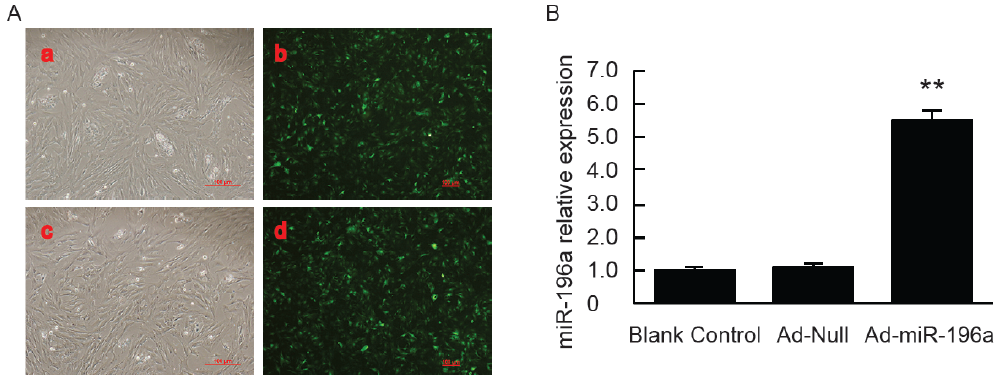
Figure 3. Overexpression of miR ‐ 196a in porcine primary adipocytes with Ad ‐ miR ‐ 196a. ( A ) Porcine primary adipocytes infected with Ad ‐ miR ‐ 196a or Ad ‐ Null for 2 days were observed under a fluorescence microscope: a and b, adipocytes infected with Ad ‐ Null (a × 200, b × 100); c and d, adipocytes infected with Ad ‐ miR ‐ 196a (c × 200, d × 100); ( B ) miR ‐ 196a expression was detected by qPCR and normalized to U6 ( n = 6 independent experiments). * = p < 0.05; ** = p < 0.01.